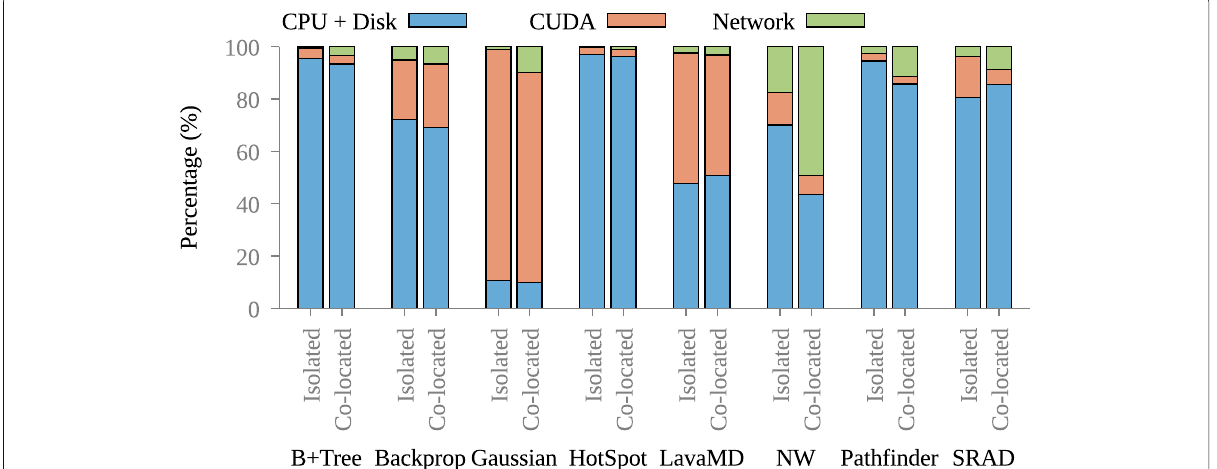
Fig. 3 Network performance analysis of disaggregated resources. Performance breakdown for different Rodinia applications running with HFCUDA in collocation with a network-intensive workload (Iperf), or running solo in